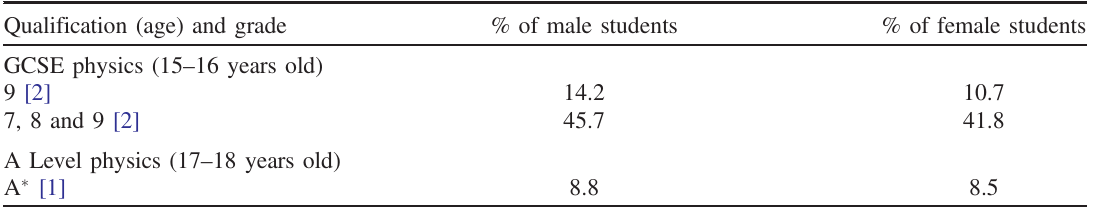
TABLE I. Student performance by gender for different qualifications and grade in 2019. A grade 9 (highest grade) is equivalent to an A (cid:1) , and grades 7, 8, and 9 are altogether equivalent to grades A and A (cid:1) (highest two grades). Qualification (age) and grade